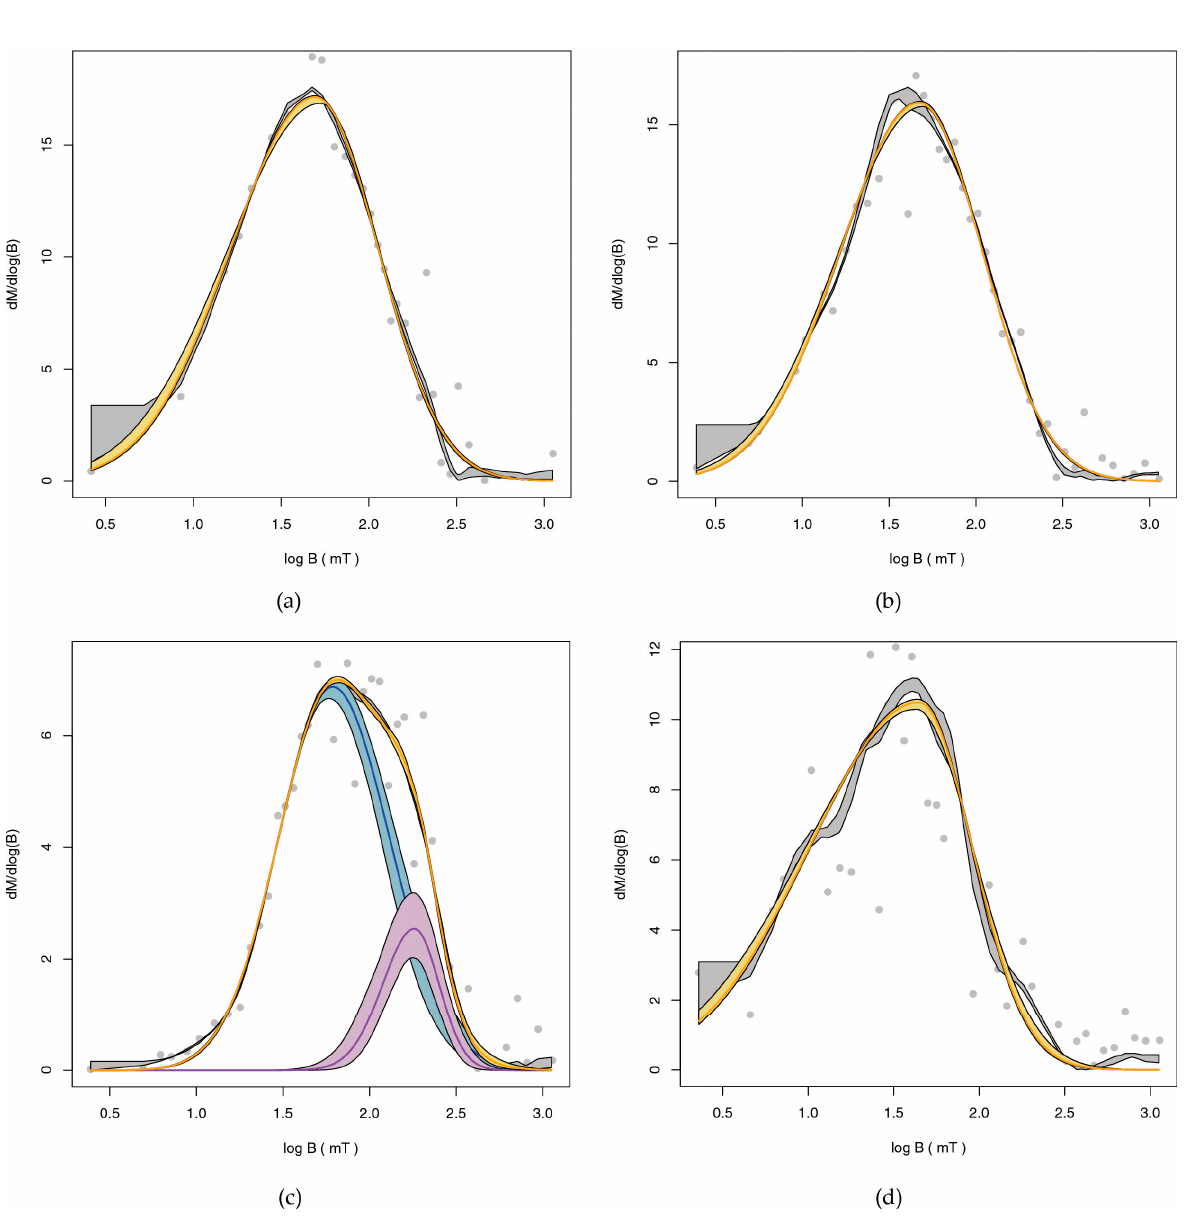
Table 1. Isothermal remanent magnetization data from the first component of the studied samples. The Cumulative log-Gaussian (CLG) treatment allows the definition for each magnetic component: K m : magnetic susceptibility; SIRM: saturation of isothermal remanent magnetization; Bh: coercivity